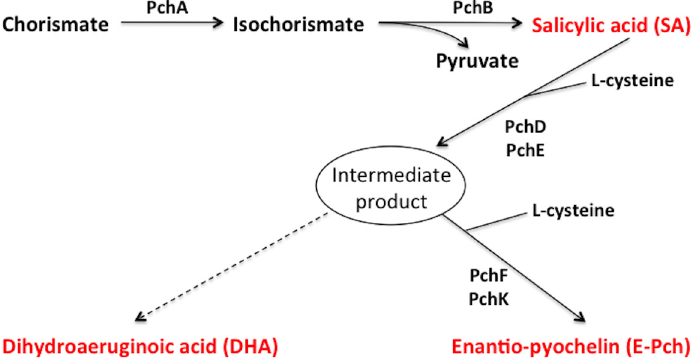
Fig 1. Pathway for biosynthesis of salicylic acid (SA), Dihydroaeruginoic acid (DHA) and Enantio- pyochelin (E-Pch), based on the information provided in Maspoli et al., 2014 [30].